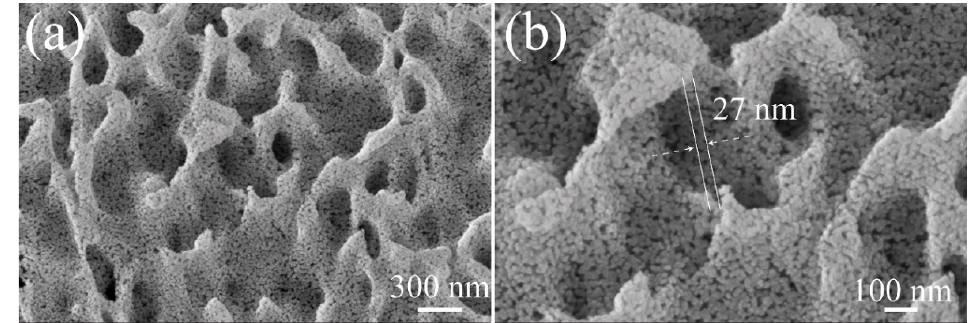
Figure 4. (a) FE-SEM images of 10C-CM/T (100 K X); ( b ) FE-SEM images of 10C-CM/T (200 K X).